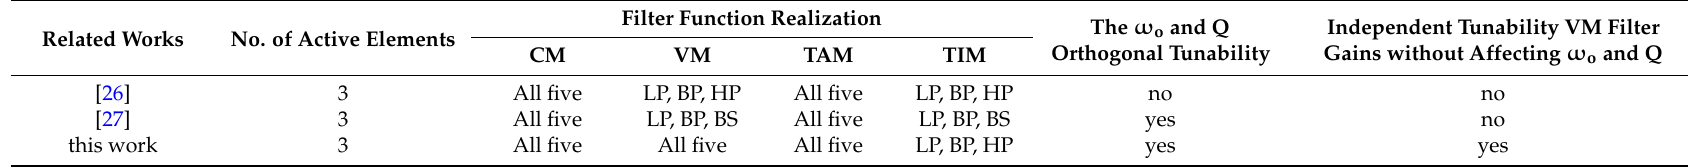
Table 3. Comparison of the proposed circuit with previously reported single-input-type of electronically tunable CCCCTA-based mixed-mode filters [26,27]. 1